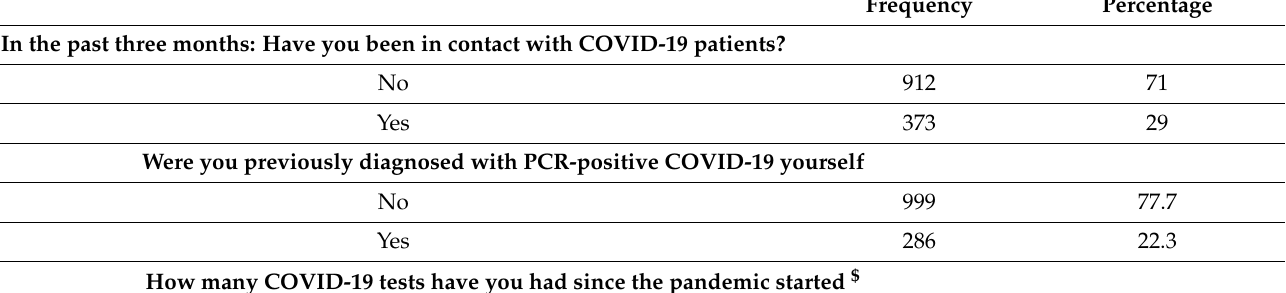
Table 2. Descriptive analysis of the HCW’s experiences of COVID-19 disease, screening, and immunization.